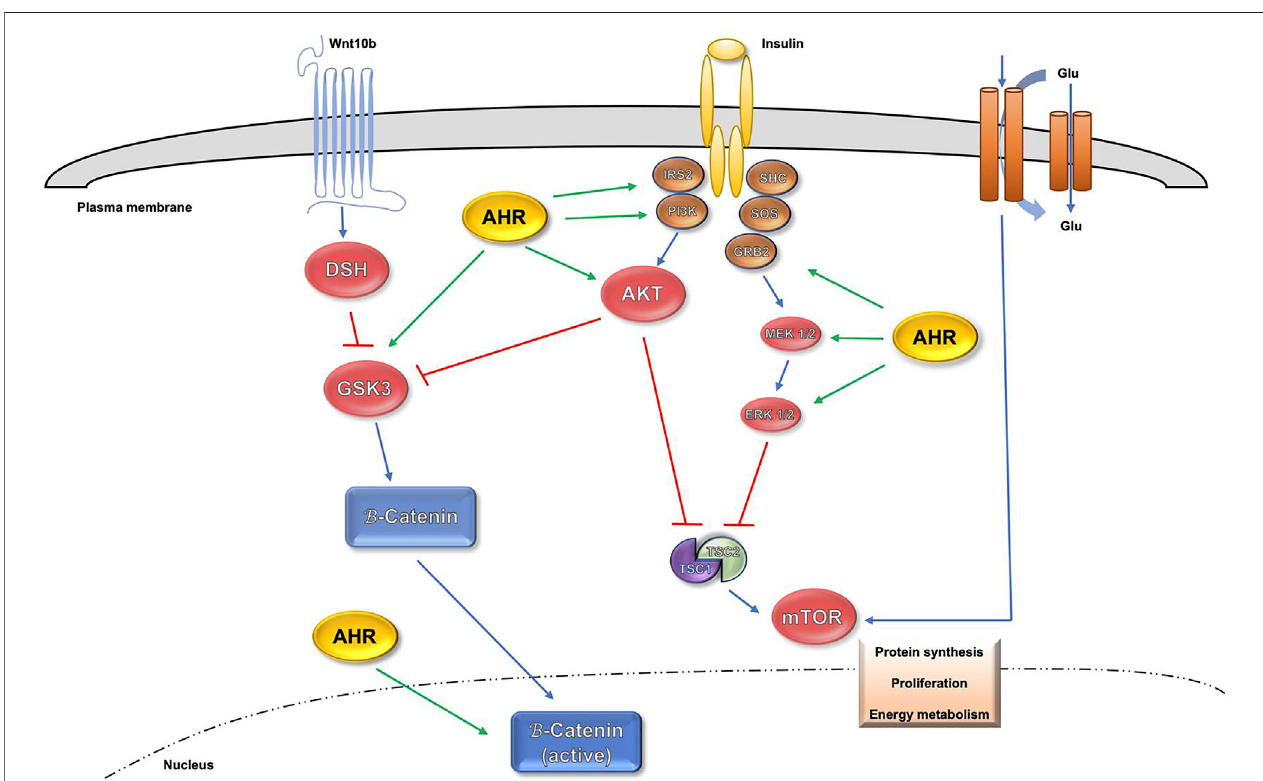
FIGURE 1 | In fl uence of AHR in AKT, mTOR and β -Catenin signaling pathways.